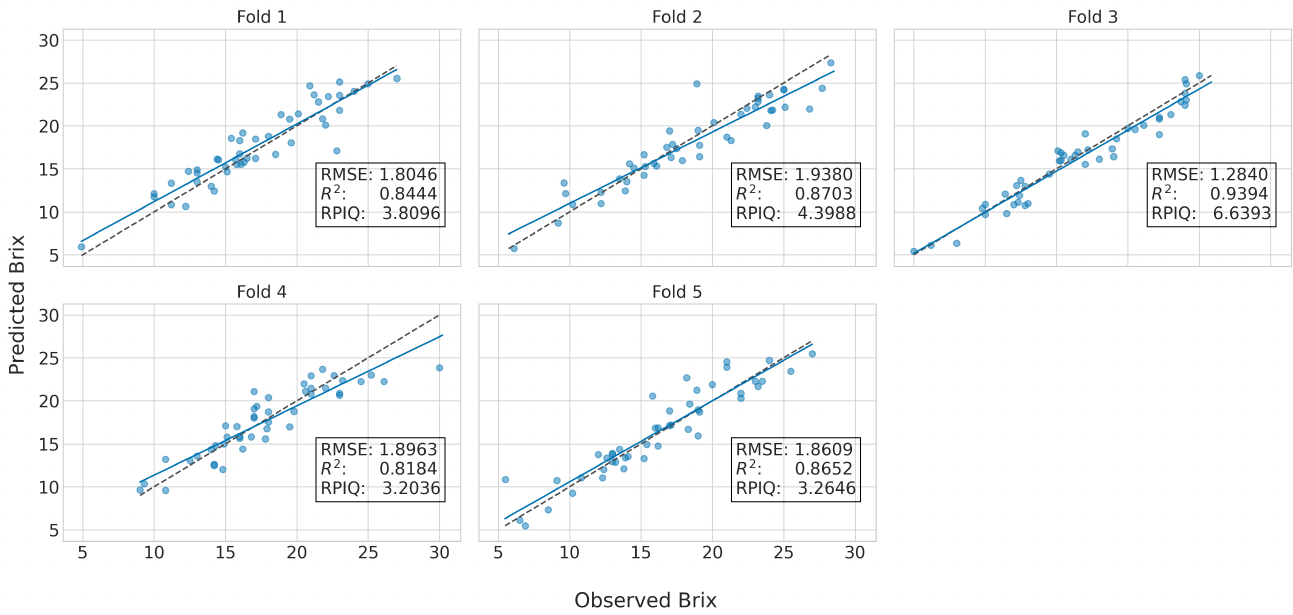
Figure 10. Predictions of the best CNN model in the Syrah variety across the five folds in the independent test set; the dashed line is the main diagonal whereas the continuous line is the least squares